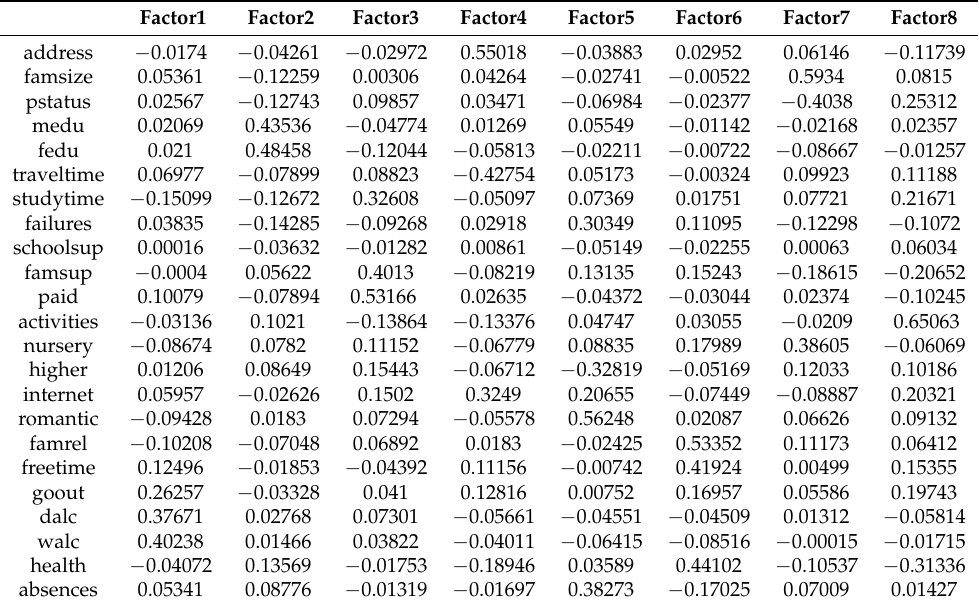
Table 2. Results of factor analysis